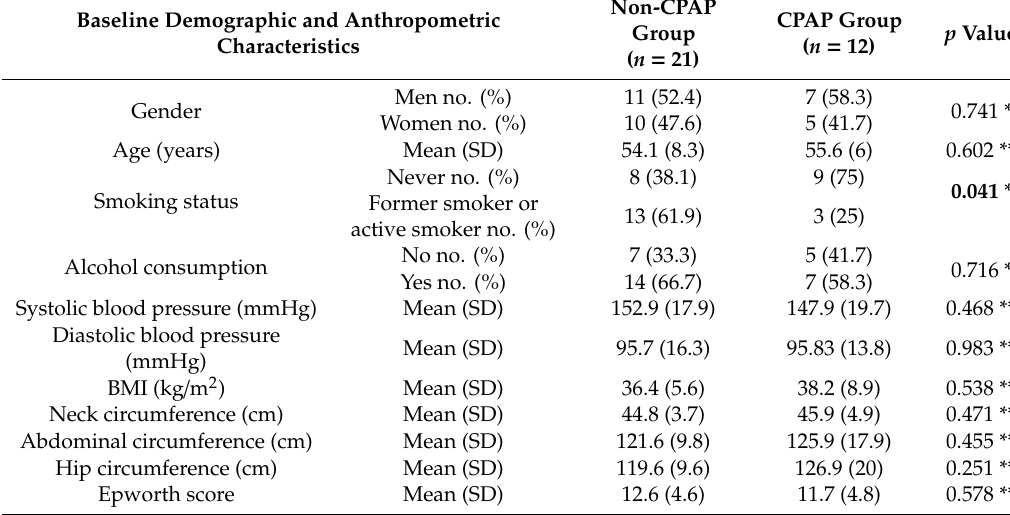
Table 1. Baseline demographic and anthropometric characteristics according to CPAP usage status at follow-up visit.